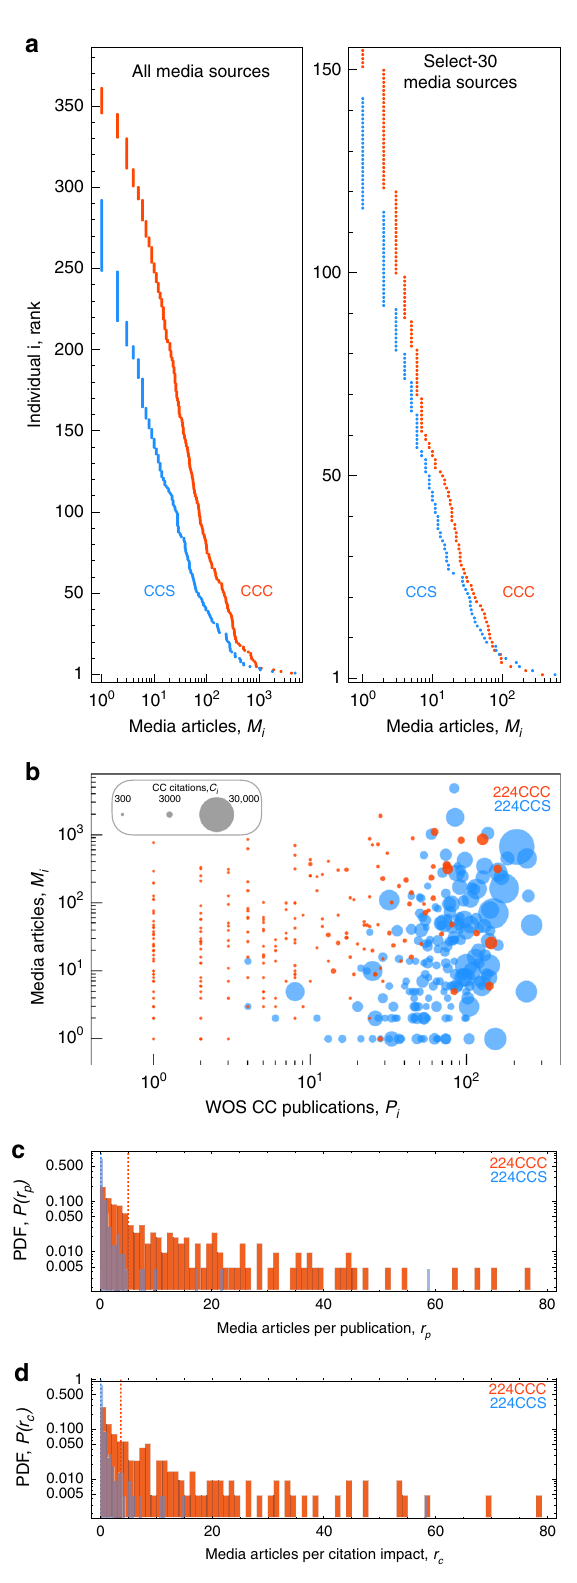
Fig. 4 Discrepancy in scienti fi c authority and media visibility — individual level. a Individuals ranked by their number of media articles, M i . (right) M i calculated using select-30 mainstream media sources only. b Scatter plot of individuals comparing Web of Science publications P i versus media visibility M i ; point size is proportional to the log of total citations, ln C i . c Probability distribution P ( r p ) of media visibility per publication, r p ≡ M i / P i ; vertical dashed line indicates the distribution median. d Probability distribution P ( r c